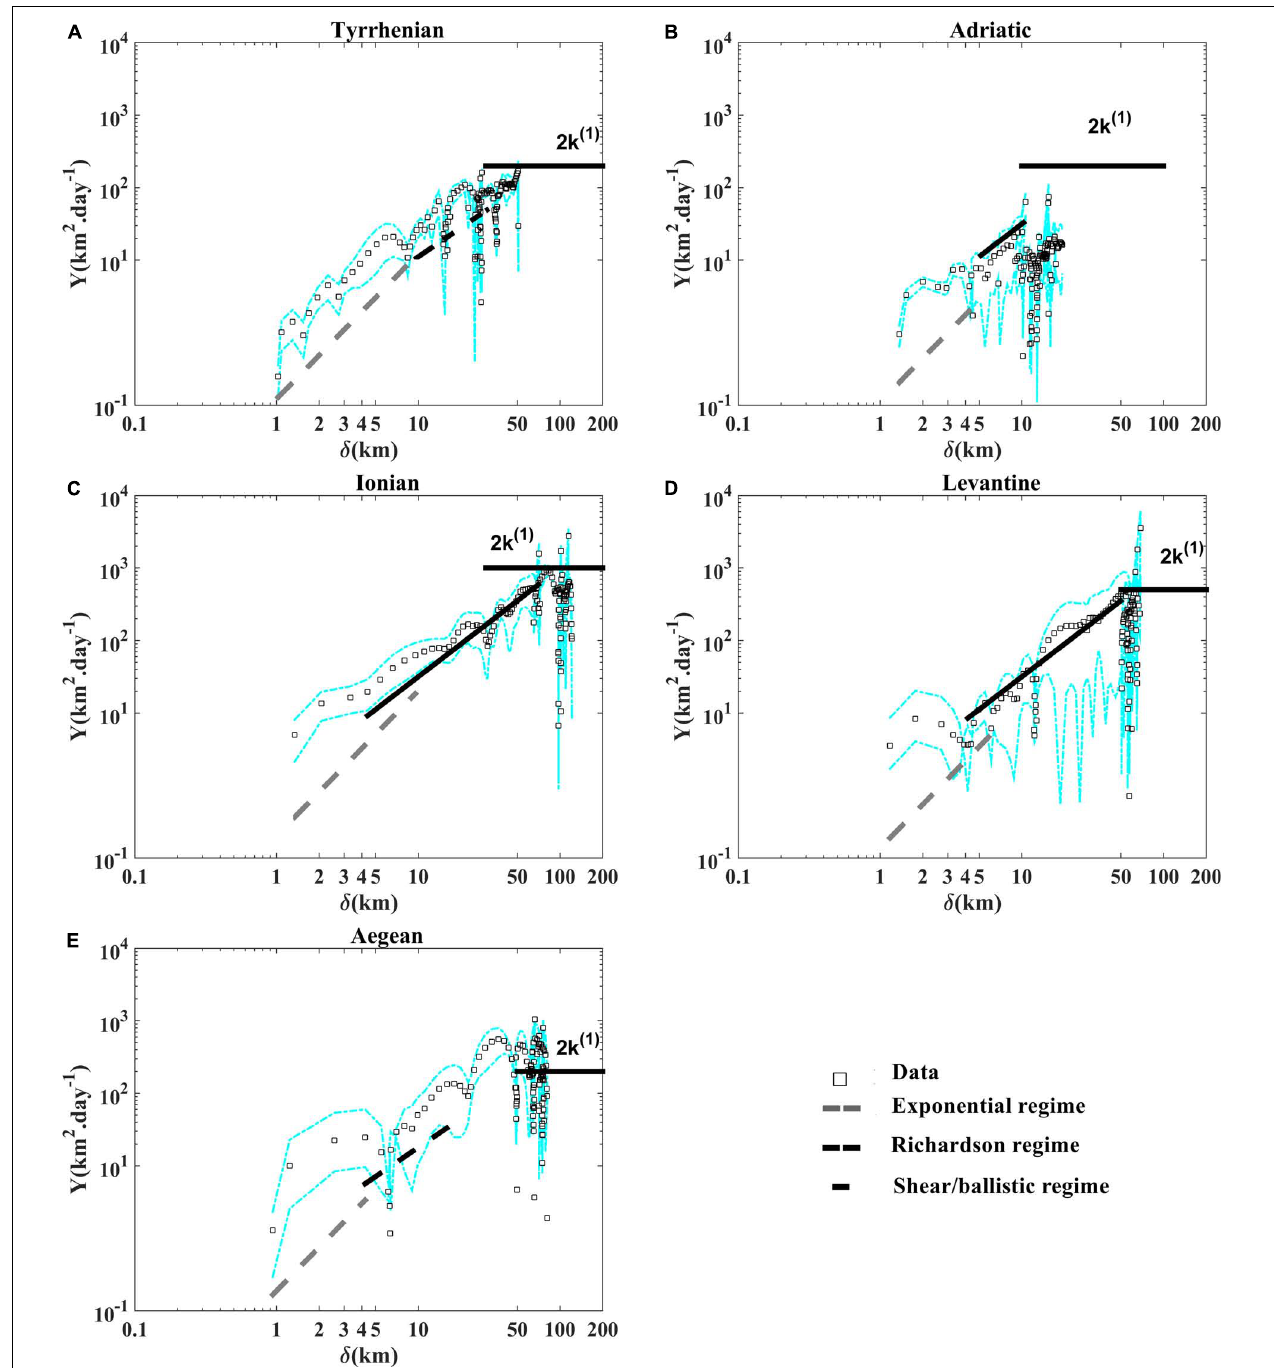
FIGURE 9 | Relative diffusivity as a function of separation distance derived from the relative dispersion in Eq. 4 (A) in the Tyrrhenian, (B) the Adriatic, (C) the Ionian, (D) the Levantine, and (E) the Aegean sub-basins. The exponential, the Richardson and the shear/ballistic regimes are shown with the dashed gray, dashed black and black lines, respectively. The diffusive regime is shown with the horizontal thick black line. The dashed cyan lines indicate the 90% confidence intervals from bootstrap resampling, give a rough idea of the uncertainties for the statistics.